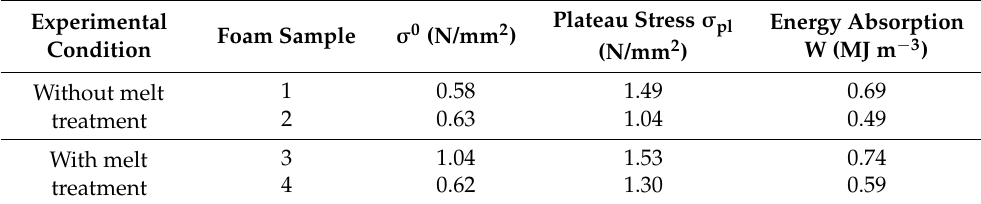
Table 4. Experimental mechanical properties and energy-absorption capacity of the A356 aluminum alloy